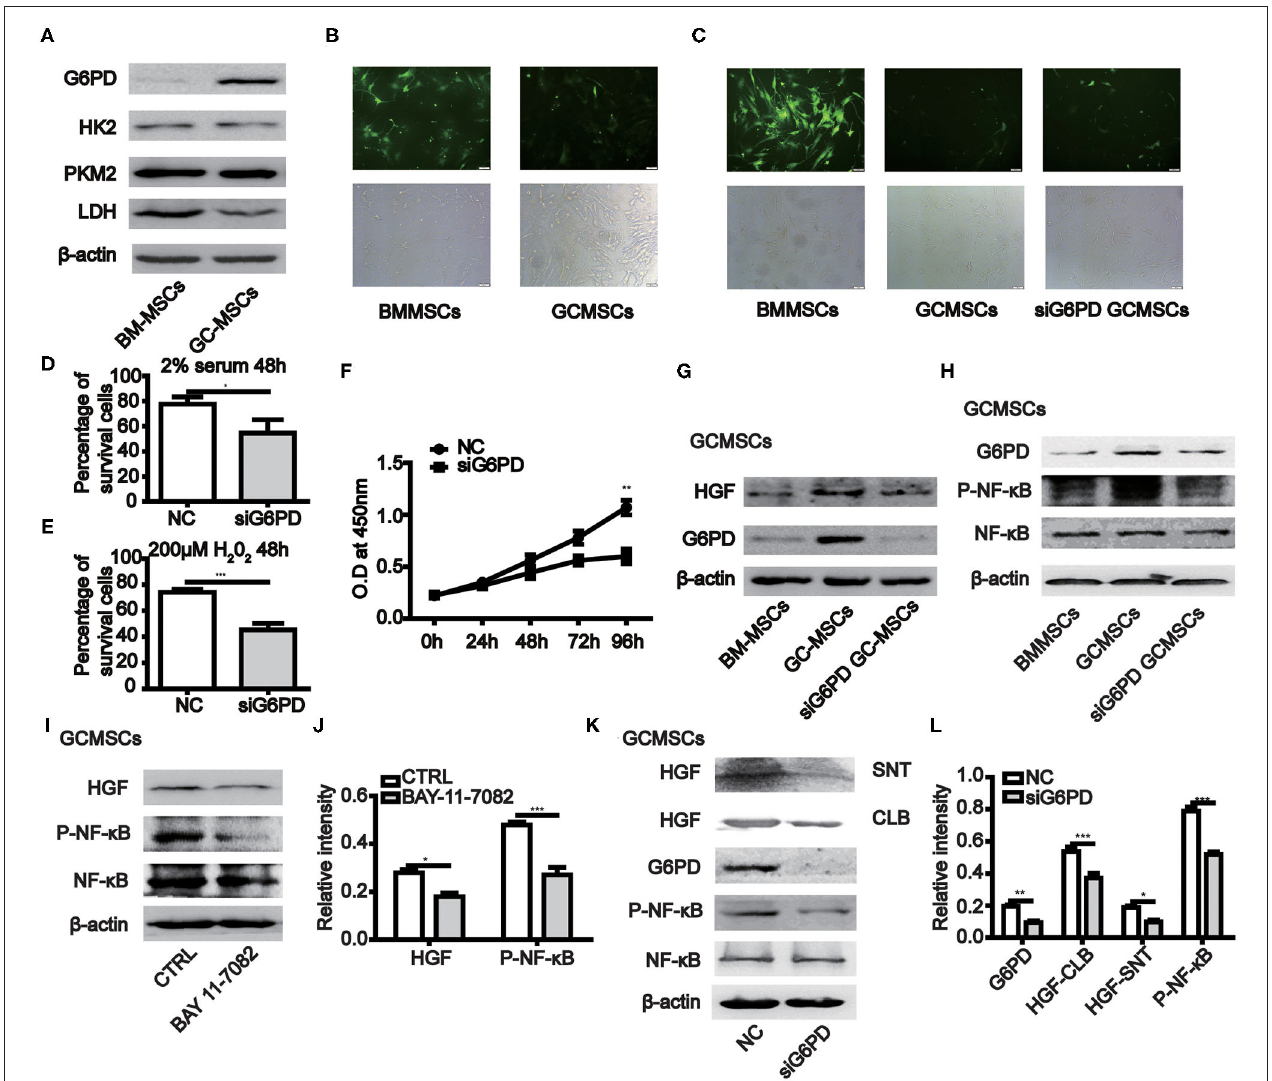
FIGURE 4 | The expression of G6PD in MSCs promotes the growth of MSCs and the production of HGF. (A) Immunoblotting of the HK2, PKM2, LDH, and G6PD expression in BMMSCs and GCMSCs. (B) ROS levels in BMMSCs and GCMSCs were detected using the ROS assay kit. (C) ROS level in BMMSCs, GCMSCs, and GCMSCs transfected with siG6PD was detected using the ROS assay kit. (D,E) Cell viability assay of GCMSCs treated with DMEM containing 2% serum (D) or 200 µ M H 2 O 2 (E) following transfection with siG6PD or NC for 48h. (F) Proliferation of GCMSCs transfected with siG6PD or negative control (NC) was detected by CCK-8 assays. (G) Immunoblotting of the G6PD and HGF expression in BMMSCs, GCMSCs, and GCMSCs transfected with siG6PD. (H) Immunoblotting of p-NF- κ B, total NF- κ B, and G6PD in BMMSCS, GCMSCs, and GCMSCs transfected with siG6PD. (I) Immunoblotting of p-NF- κ B, total NF- κ B, and HGF in GCMSCs treated with BAY 11-7082 (5nM) and untreated GCMSCs. (J) Quantitative statistics of the p-NF- κ B and HGF expression in different groups. (K) Immunoblotting of p-NF- κ B, total NF- κ B, supernatant (SNT) HGF, and HGF in GCMSCs (CLB) transfected with siG6PD and GCMSCs not transfected with siG6PD. (L) Quantitative statistics of the G6PD, p-NF- κ B, and HGF expression in different groups ( n = 3; * P < 0.05; ** P < 0.01; *** P < 0.001).